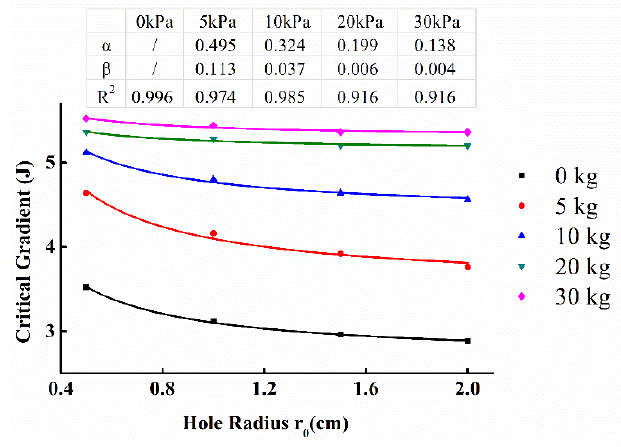
Figure 10. Fitting results of the theoretical model and experimental data.